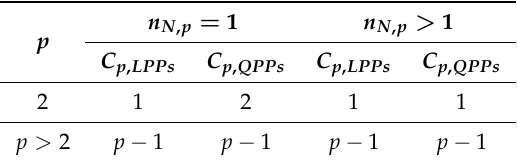
Table 1. The number of all linear permutation polynomials (LPPs) and quadratic permutation polynomials (QPPs) over Z p permuting Z